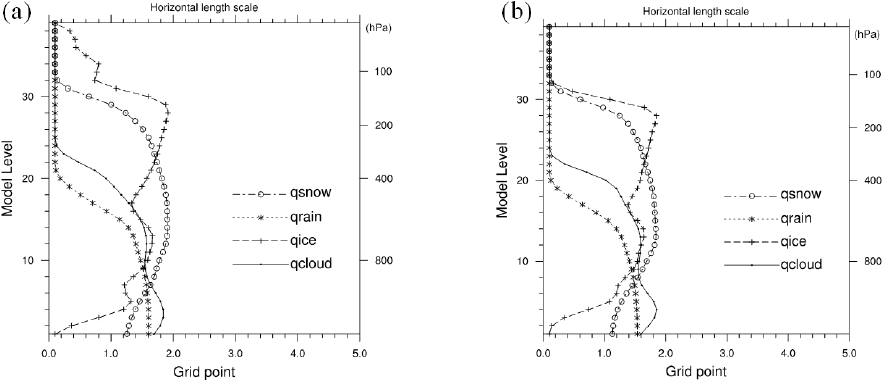
Figure 15. Horizontal length scale for the hydrometeors using (a) 50 members and (b) using 5 members. The plots show similar character- istics regardless of the ensemble members (WRF, res. 15km,